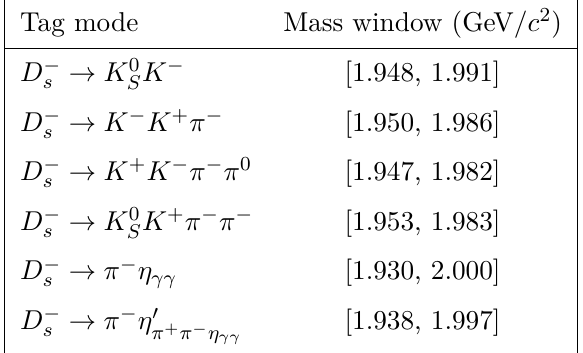
Table 2 . The M tag requirements for various tag modes, where the subscripts of η and η 0 denote the decay modes used to reconstruct these particles.